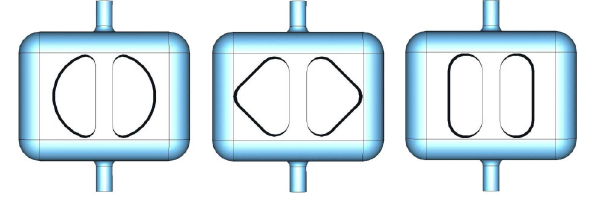
TABLE II. Properties of parallel-bar cavities with different cross sections shown in Fig.